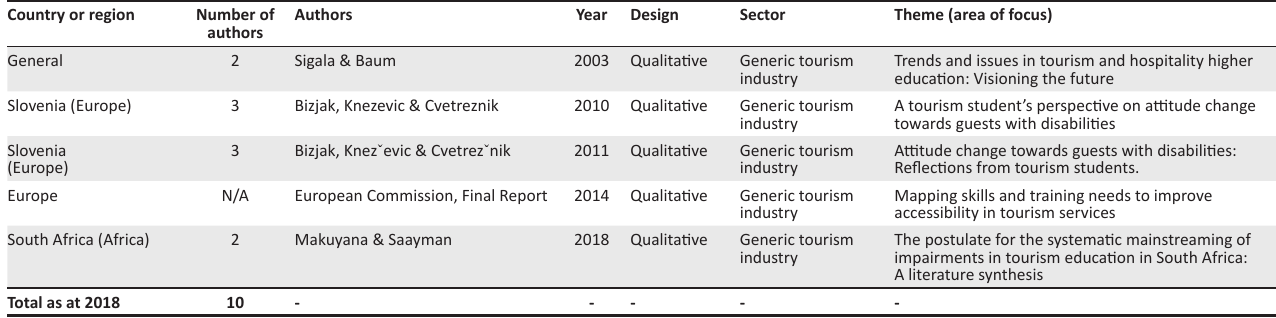
TABLE 8: Research on tourism education and/or skills development, impairments and